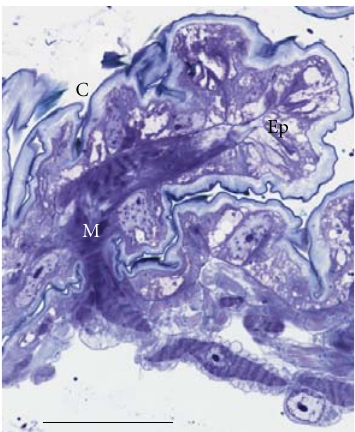
Figure 8: Detail of the epithelium (Ep), muscles (M), and cuticle (C) of the pharynx of a N. abietis larva. Scale bar = 30 μ m.